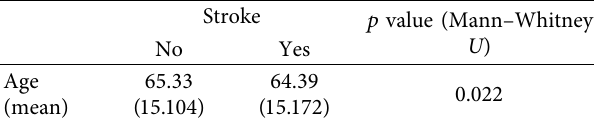
Table 3: Association of age and stroke.